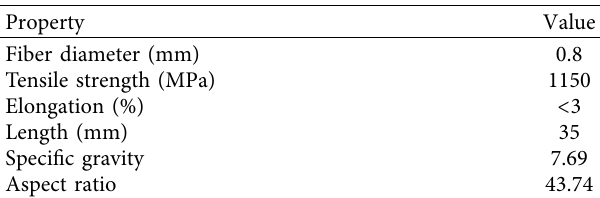
Figure 2: Steel fbers used in this study (a) separately and (b) in the mixture. Table 6: Properties of steel